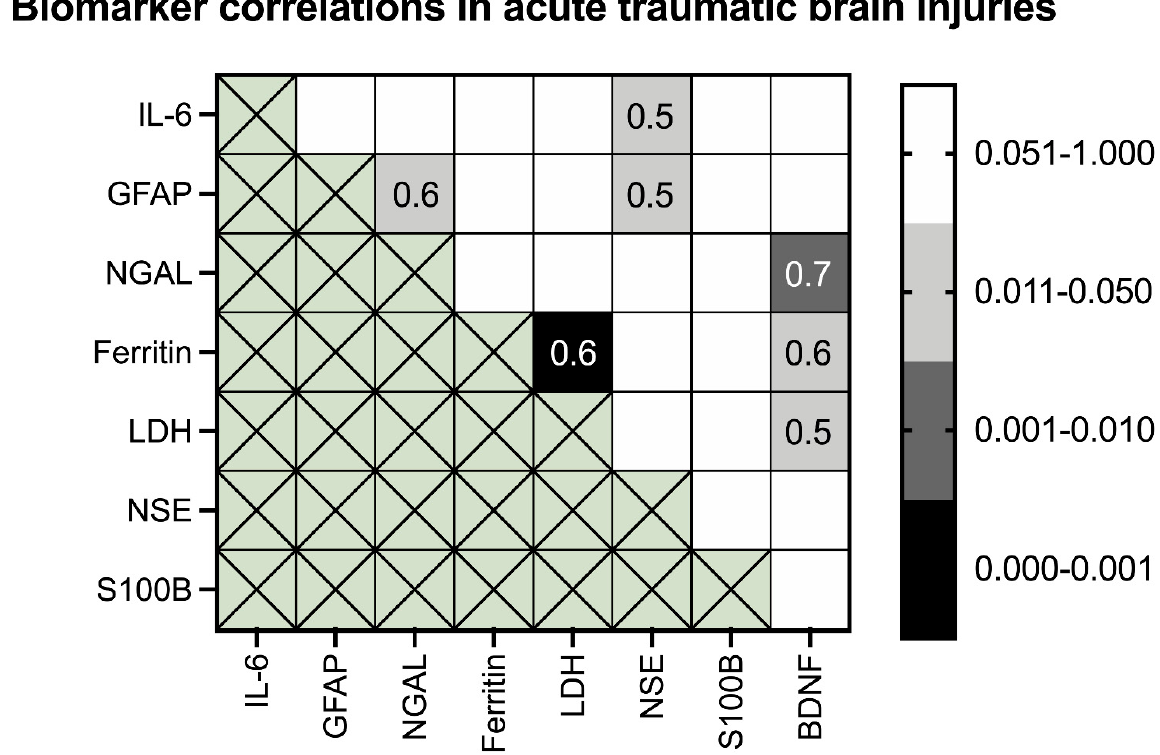
Figure 4. A heat map displaying the correlations between the cerebrospinal fluid biomarkers for the detection of acute lethal traumatic brain injuries. Significant p -values ( p ≤ 0.05) are shown with different intensities of grey and black. For significant correlations, the correlation coefficient was added numerically within the respective boxes.